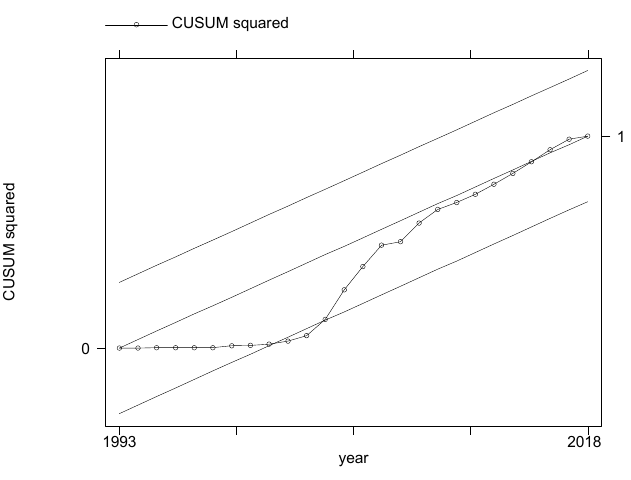
Figure 8. CUSUMQ for Model 3.